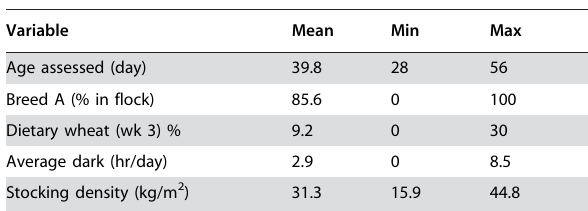
Table 4. Mean, minimum and maximum values of the continuous predictor variables in the model of average flock